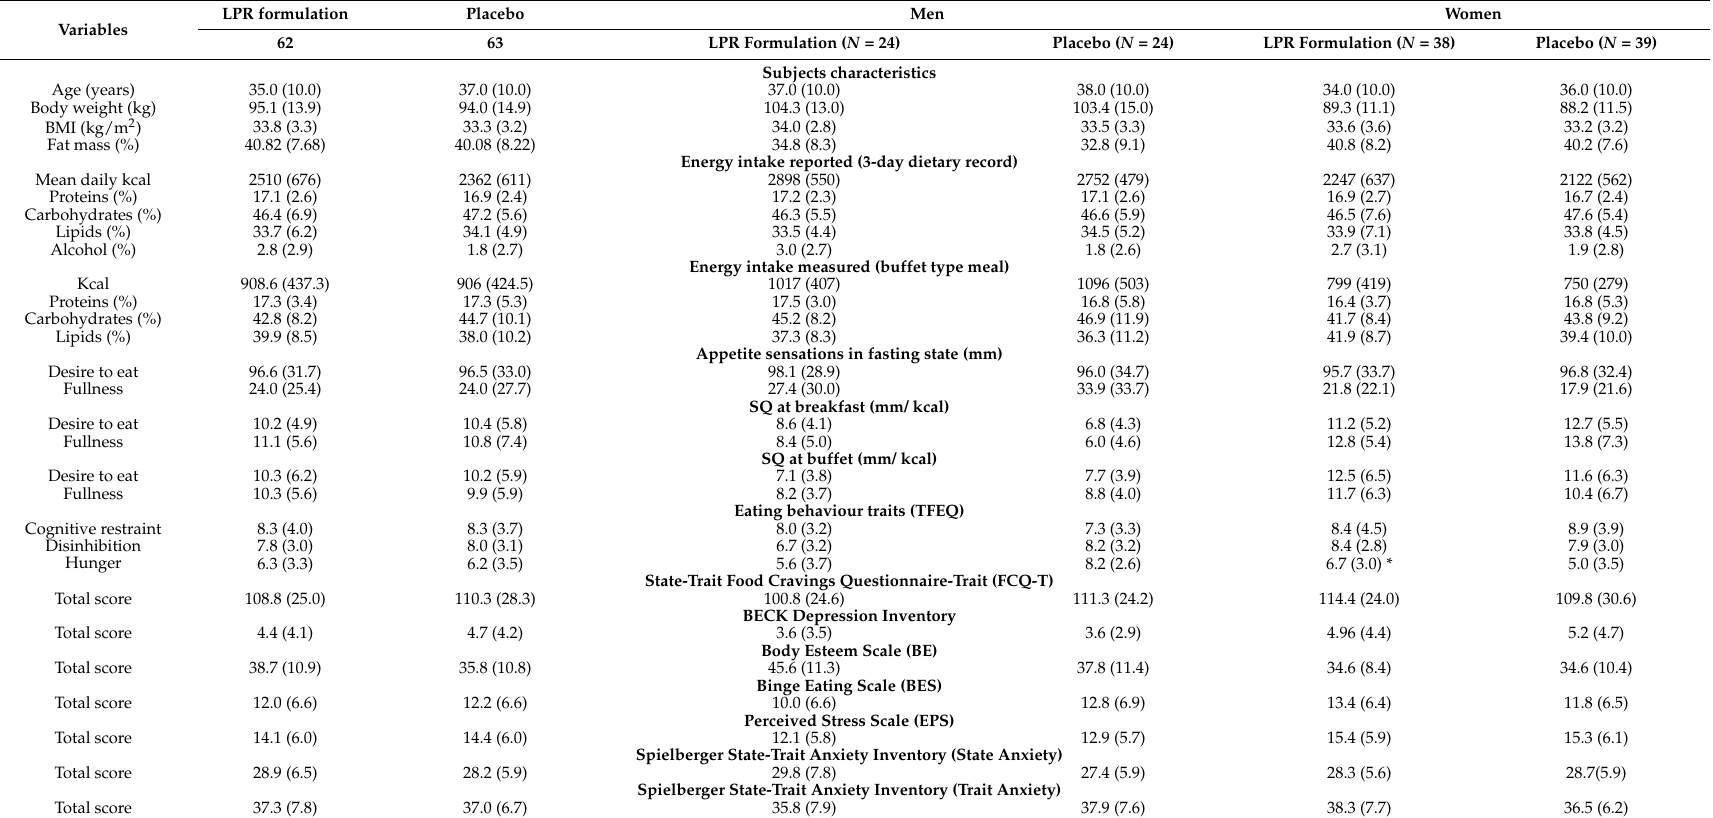
Table 1. Baseline characteristics, energy intake, appetite sensation markers, and